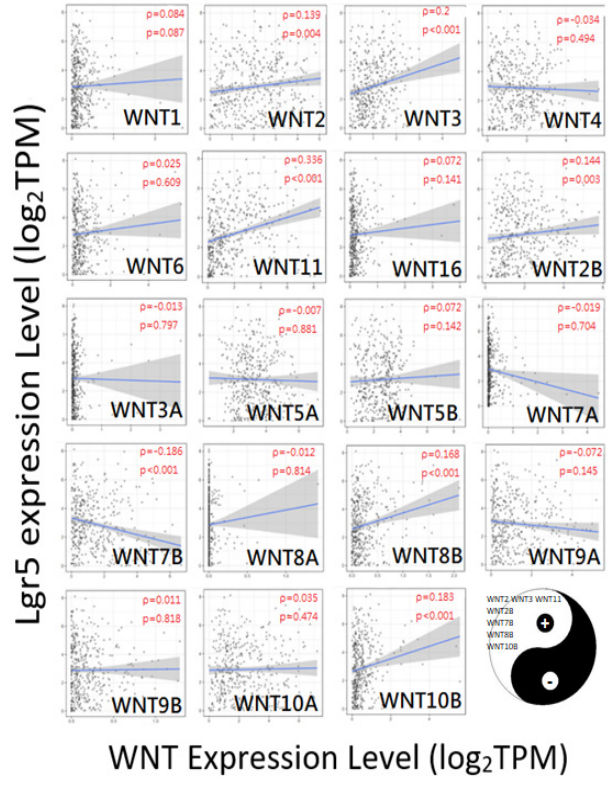
Figure 7. Correlation between CAST and the WNT family. +: significant positive correlation, WNT2 (rho = 0.139; p -value = 0.004); WNT3 (rho = 0.2; p -value < 0.001); WNT11 (rho = 0.336; p -value < 0.001); WNT2B (rho = 0.144; p -value = 0.003); WNT7B (rho = 0.186; p -value < 0.001); WNT8B (rho = 0.168; p -value < 0.001); WNT10B (rho = 0.183; p -value < 0.001). − : significant negative correlation,